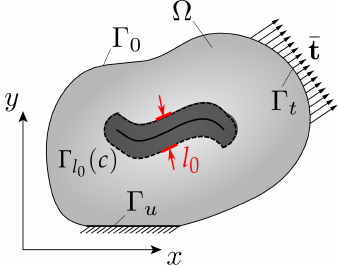
Figure 6. Description of diffused crack scaled by the length-scale parameter l 0 and boundary